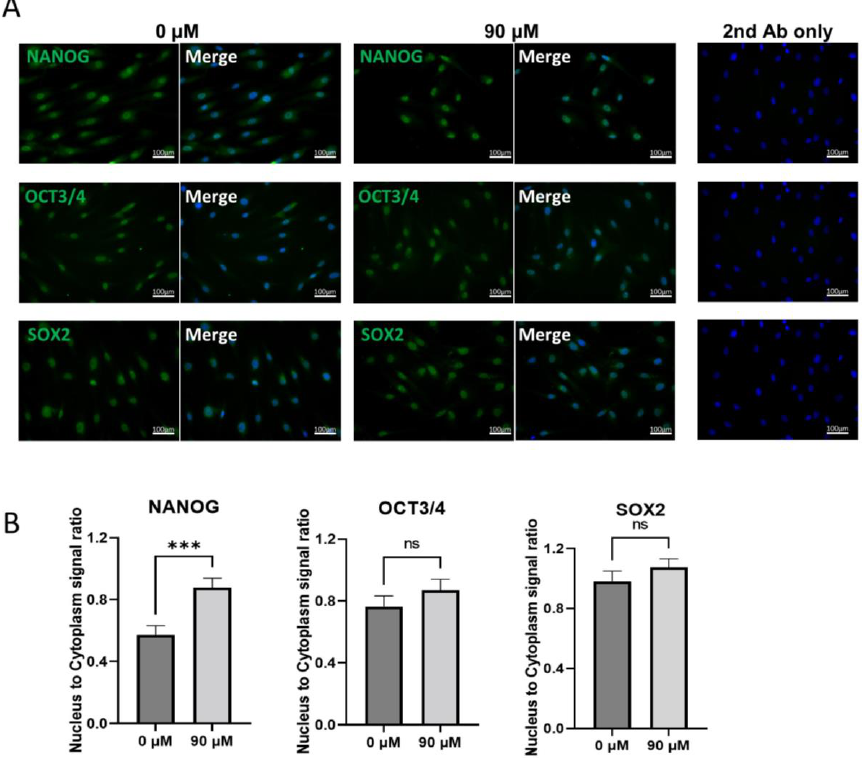
Figure 6. Localization of NANOG, OCT3/4, and SOX2 in Muse cells before and after DDT treatment. ( A ) Immunocytochemistry of untreated Muse cells (0 μM DDT) and DDT-treated Muse cells (90 μM) labeled with NANOG, OCT3/4, or SOX2 (green). Nuclei were labeled with DAPI (blue). Bars: 100 μm; ( B ) The ratio of nucleus to cytoplasm signal intensity of NANOG, OCT3/4, and SOX2 in untreated and DDT-treated Muse cells ( n = 20 each). Signal intensity was measured using ImageJ software. ***: p < 0.001, ns: no significant difference. Mann Whitney test was used for statistical anal- ysis. Data are shown as the mean ± SEM.